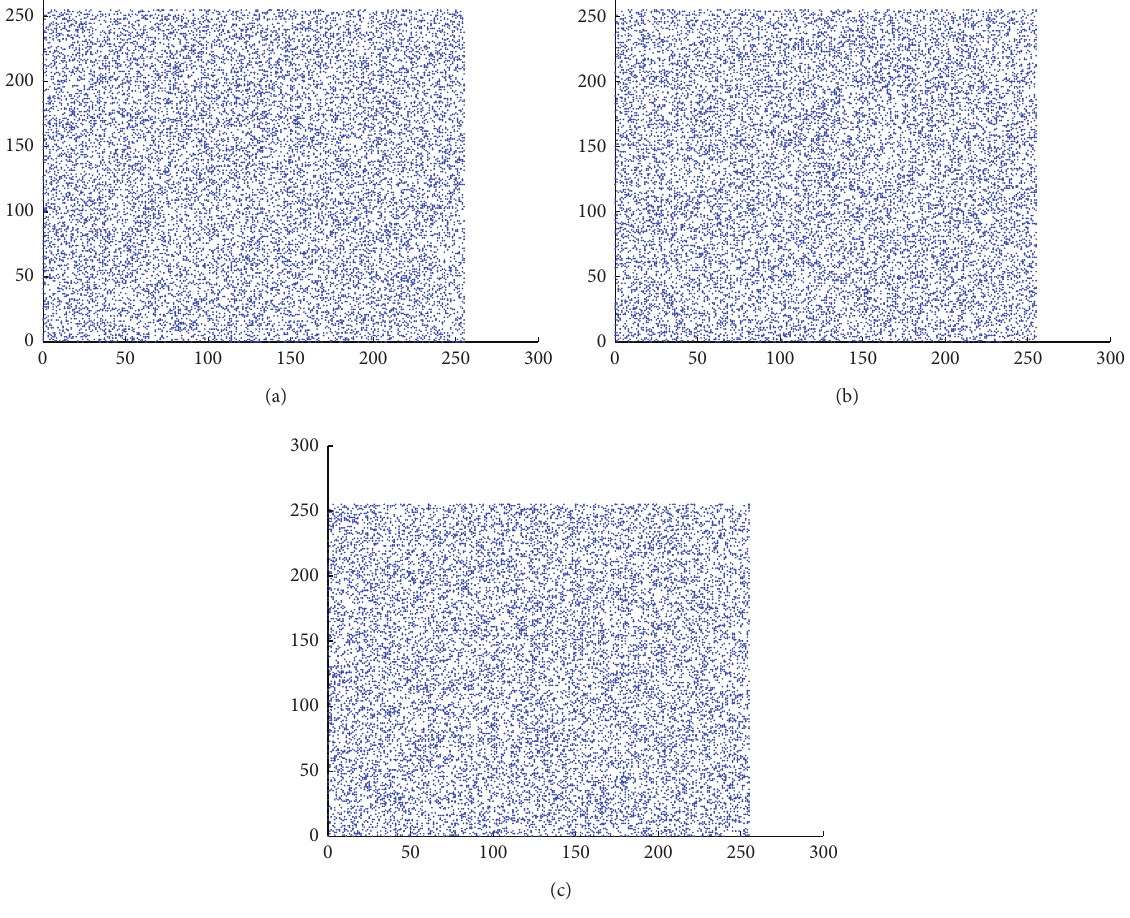
Figure 11: Correlation of cipher image’s pixels in (a) horizontal, (b) vertical, and (c) diagonal position.